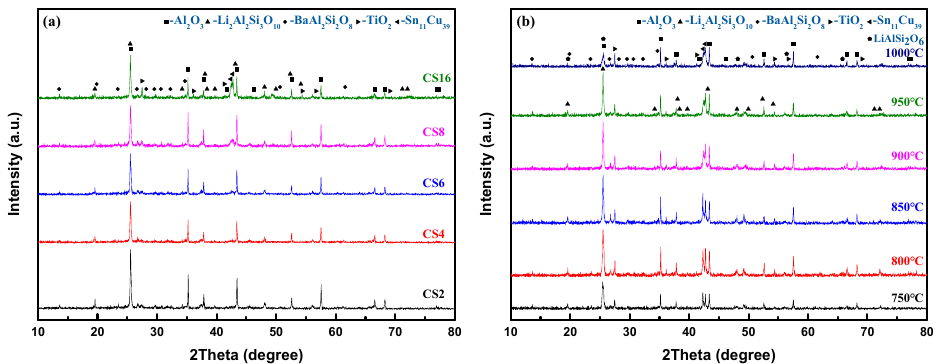
Figure 2. XRD patterns of TC composites: ( a ) the samples containing 2–16 wt% TC sintered at 950 °C; ( b ) the samples containing 16 wt% TC sintered at 750–1000 °C. ( b ) the samples containing 16 wt% TC sintered at 750–1000 ◦